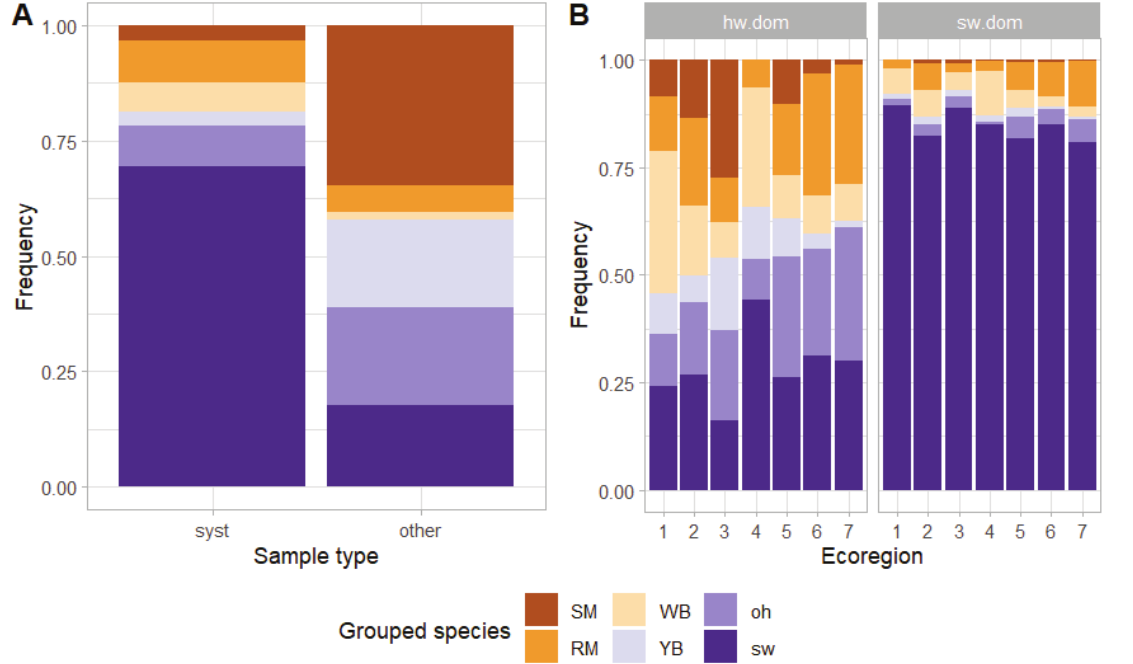
Figure 4. Species distribution (SM: sugar maple; RM: red maple; WB: white birch; YB: yellow birch; oh: other hardwoods; sw: softwoods) depending on sampling type (systematic “syst” and other) ( A ) and ecoregion (1 to 7) and plot dominance (hardwood dominated (“hw.dom”) or softwood dominated (“sw.dom”)) and ( B ), N = 253,235.